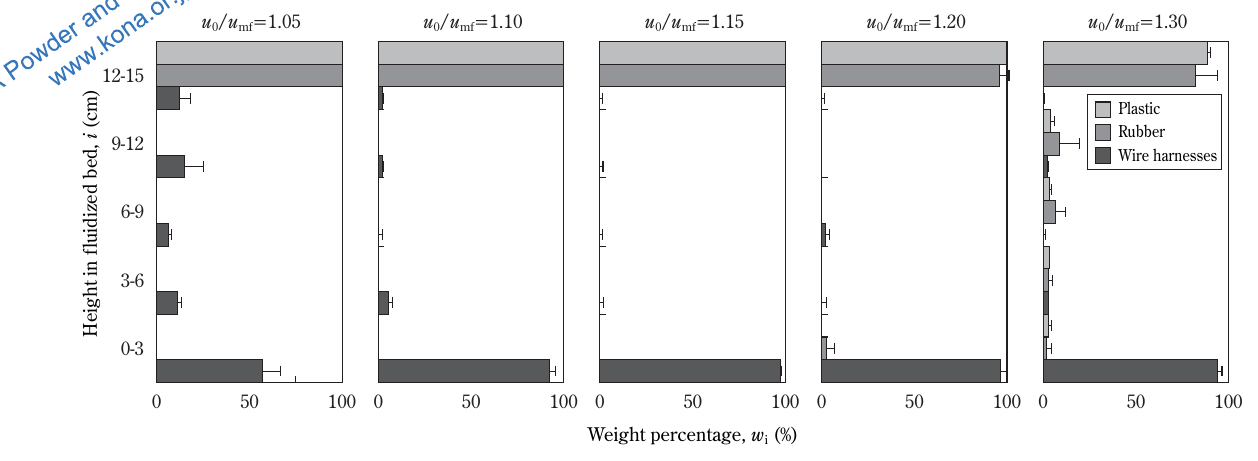
Fig. 10 Weight percentages of plastic, rubber, and wire harnesses at each height in the fluidized bed at various air velocities